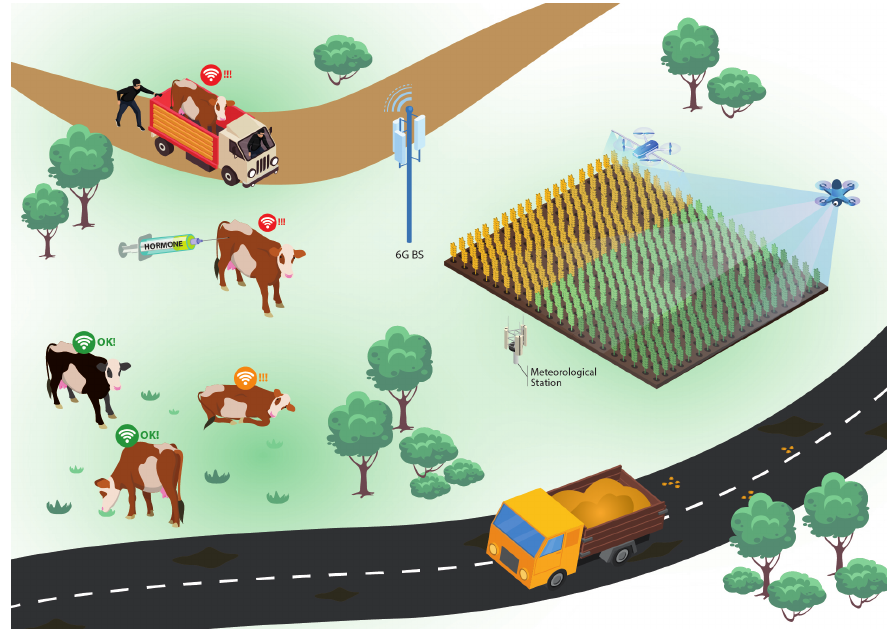
Figure 7. Advanced agribusiness use case: Future agriculture.